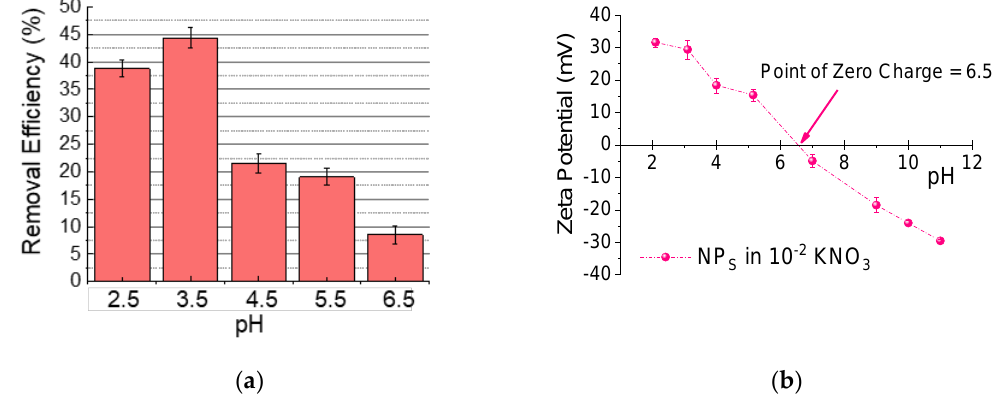
Figure 3. ( a ) E ff ect of the pH batch solution in the adsorption capacity in equilibrium when work with 1 g / L sorbent concentration and 25 mg / L of adsorbate. ( b ) Zeta potential of nanosorbent as a function of pH. Dots are connected to guide the